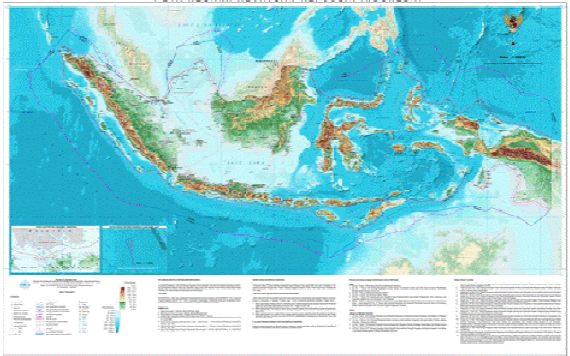
Figure 1. Study Area (Source: Peta Negara Kesatuan Republik Indonesia , © BAKOSURTANAL